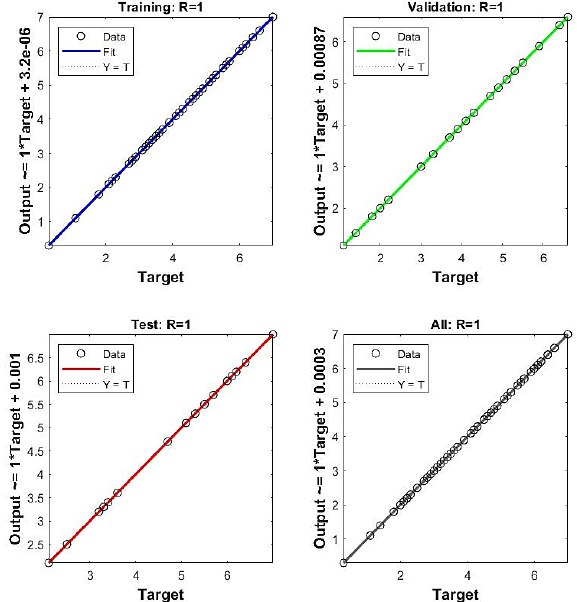
Fig. 6. 1 (R) in each subset (training, validation and test set), but also in the sample as a